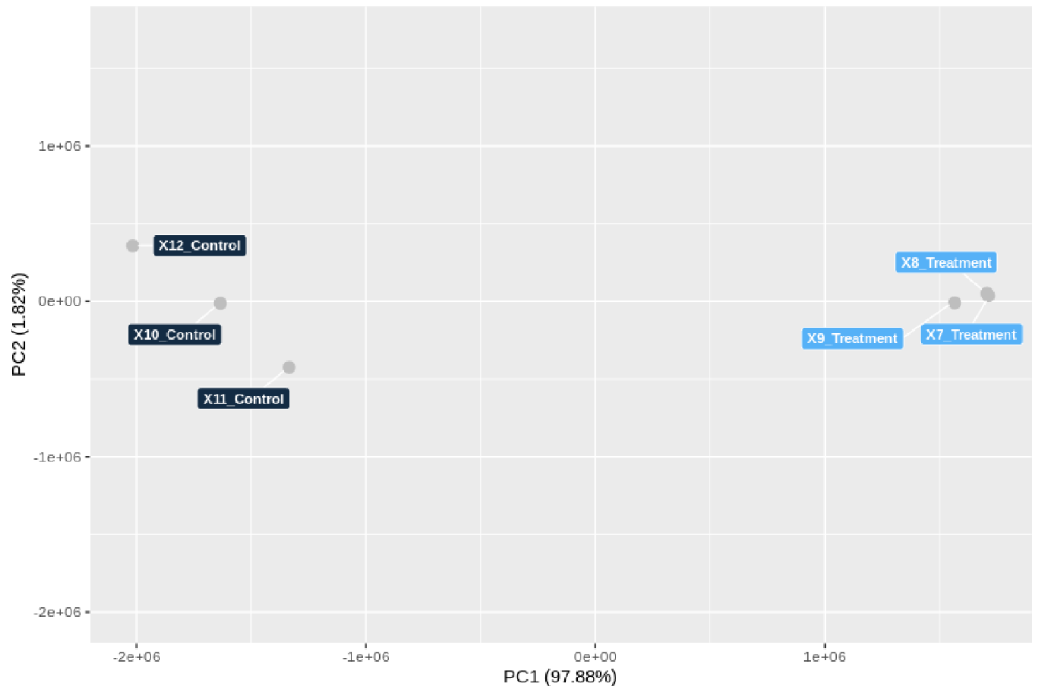
Figure 5. Principal Component Analysis (PCA) conducted on the normalized gene expression values of the samples (control and DDT treatment). X- and Y-axes show the PC1 and PC2, respectively, with the amount of variance explained by each component reported in parenthesis. Each point in the plot represents a sample, dots of the same colours are replicates of a same experimental group. PCA showed that replicates cluster together for both control and treatment, and the treatment group is clearly distinct from the control group.